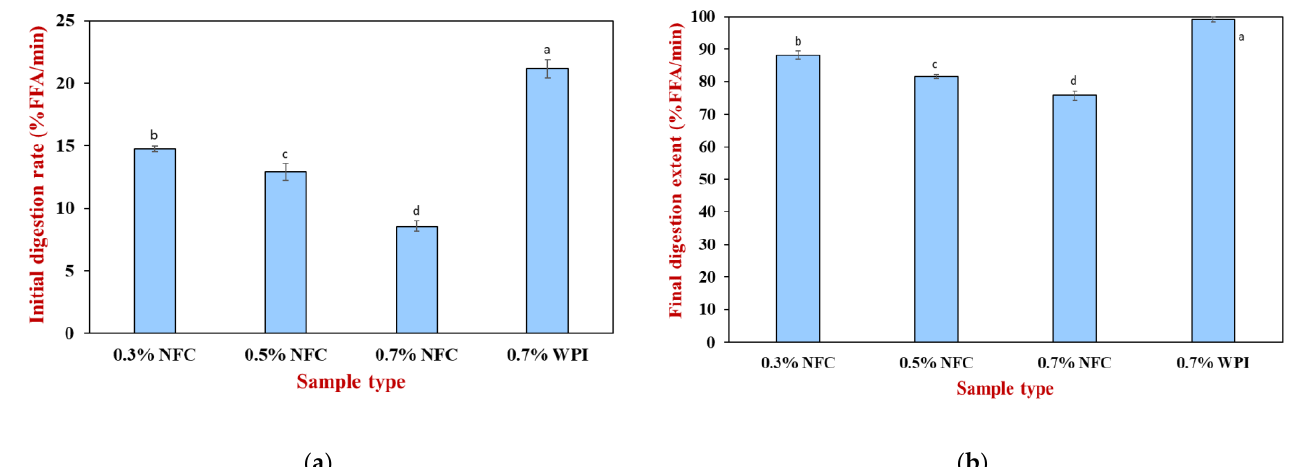
Figure 6. ( a ) Initial digestion rate; ( b ) final digestion extent of AX-loaded emulsions prepared with nanofibrillated cellulose and whey protein. Different lowercase letters (a–d) determine a significant difference in the samples (Tukey, p ≤ 0.05).